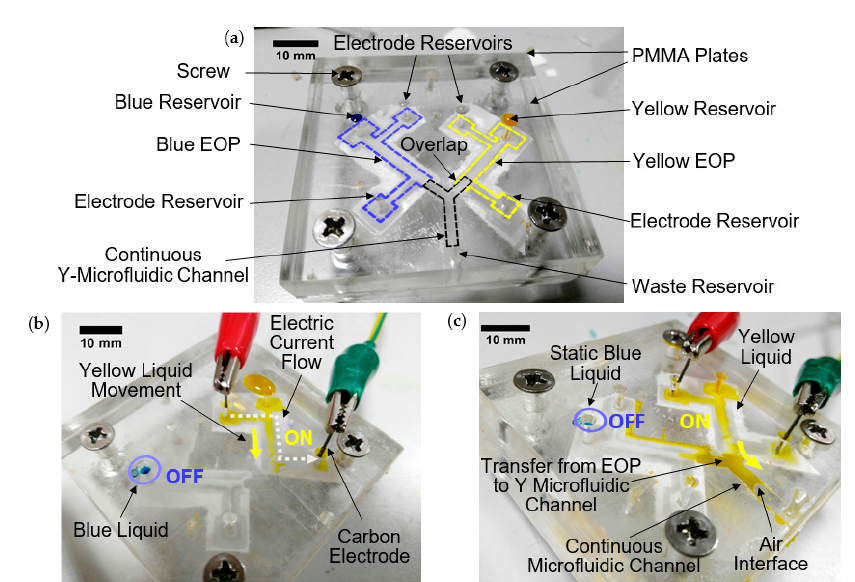
Figure 7. ( a ) Demonstration of motion control of two different liquids with two integrated EOPs and a continuous Y-shaped microfluidic channel; ( b ) Yellow EOP is turned on while blue EOP is turned off; ( c ) Yellow liquid passes from porous EOP to continuous microfluidic channel while blue liquid is